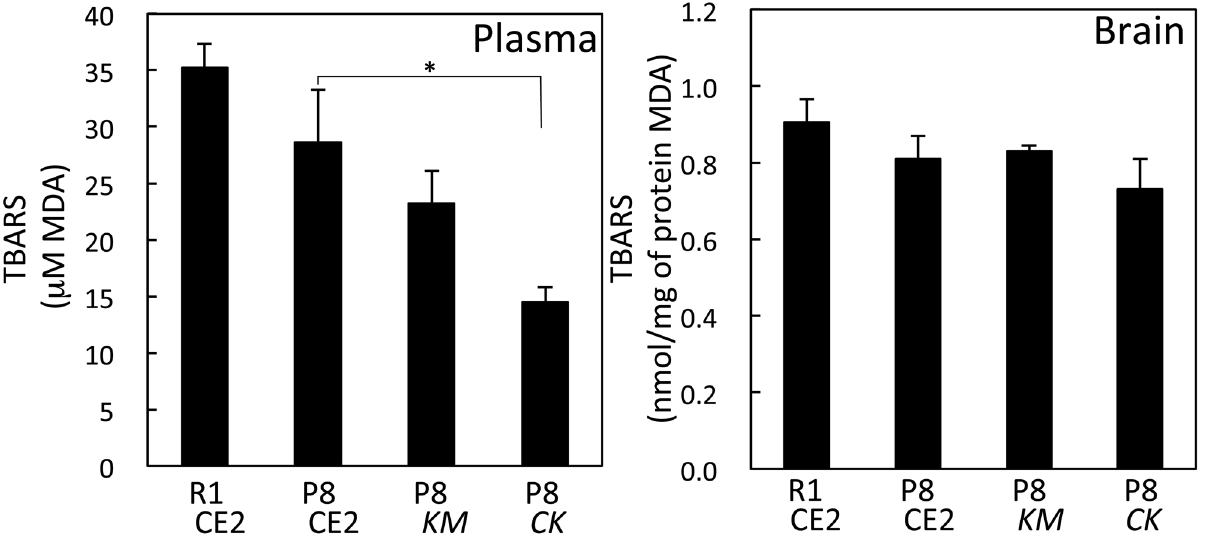
Fig 2. Level of TBARS in serum and brain homogenates in 4-month-old senescence-accelerated mice. Levels of TBARS in serum were measured (R1 CE2, n = 16; P8 CE2, n = 9; P8 KM , n = 9; P8 CK , n = 9) and brain homogenates (R1 CE2, n = 13; P8 CE2, n = 6; P8 KM , n = 6; P8 CK , n = 6). Results are expressed as mean ± SE. * p < 0.05, vs .